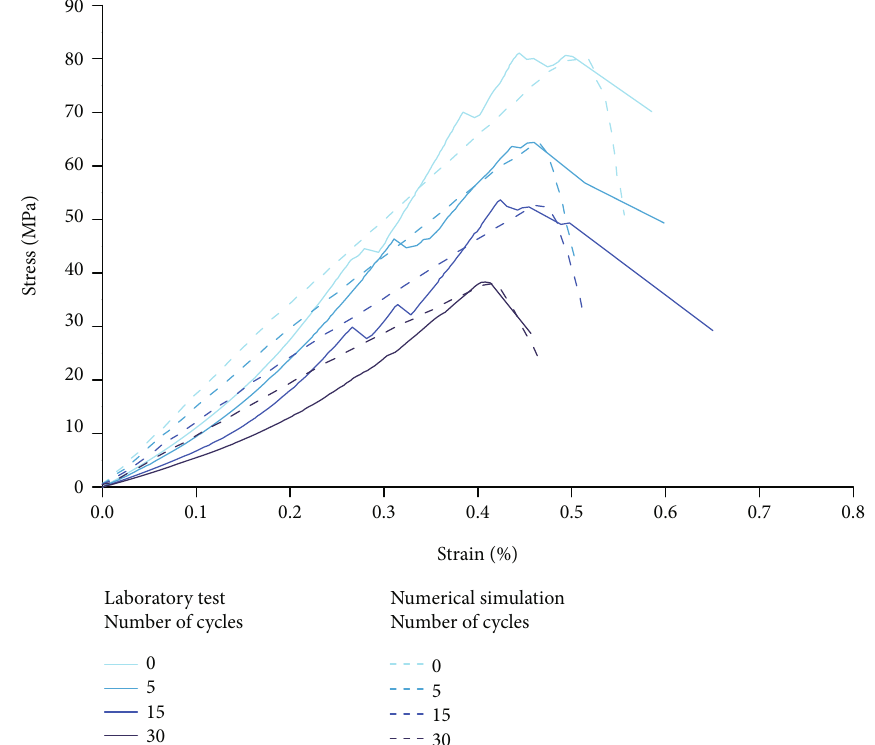
Figure 7: Stress-strain curve of uniaxial compression test.